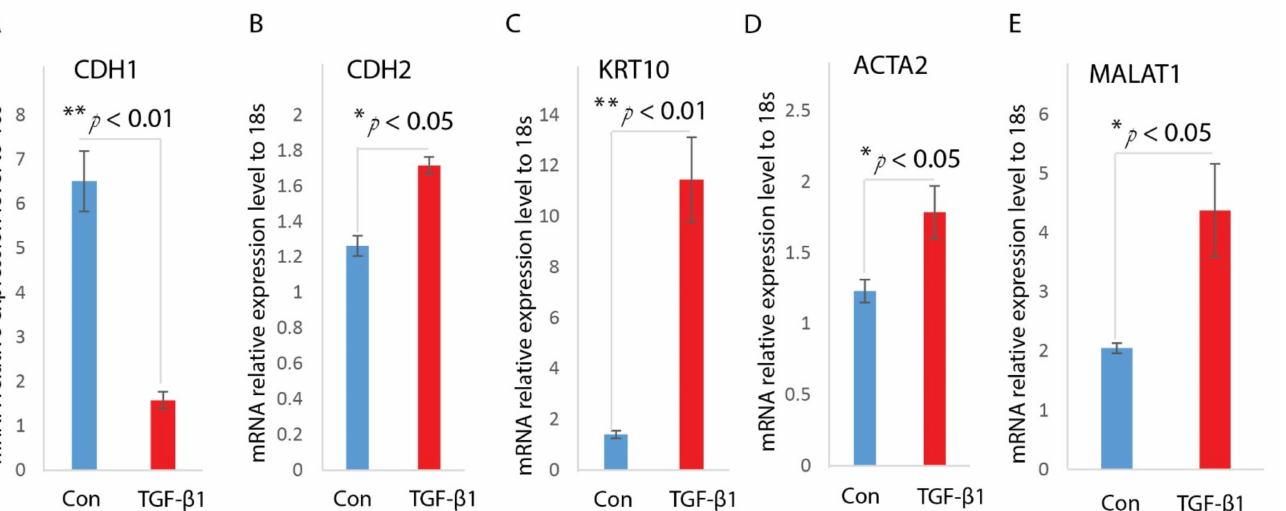
Figure 1. TGF- β 1 and MALAT1 expression are significantly higher in diabetic wounds. ( A ) Realtime qPCR analysis of TGF- β 1 mRNA expression in mouse diabetic and non-diabetic wounds at day 3 (mean ± SD, n = 5 per group) and day 7 (mean ± SD, n = 5 per group) after injury. ( B ) Realtime qPCR analysis of MALAT1 mRNA expression in mouse diabetic and non-diabetic wounds at day 3 (mean ± SD, n = 5 per group) and day 7 (mean ± SD, n = 5 per group, * p < 0.05, ** p < 0.01) after injury.